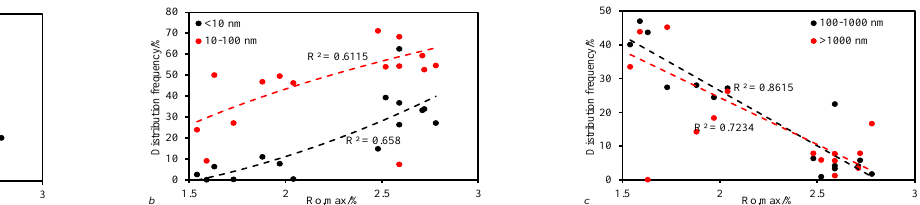
Figure 4. The relationships between R o,max and the pore distribution frequency parameters. (( a ) R o,max vs. ρ 2 ( b ) and ( c ) R o,max vs. distribution frequency).